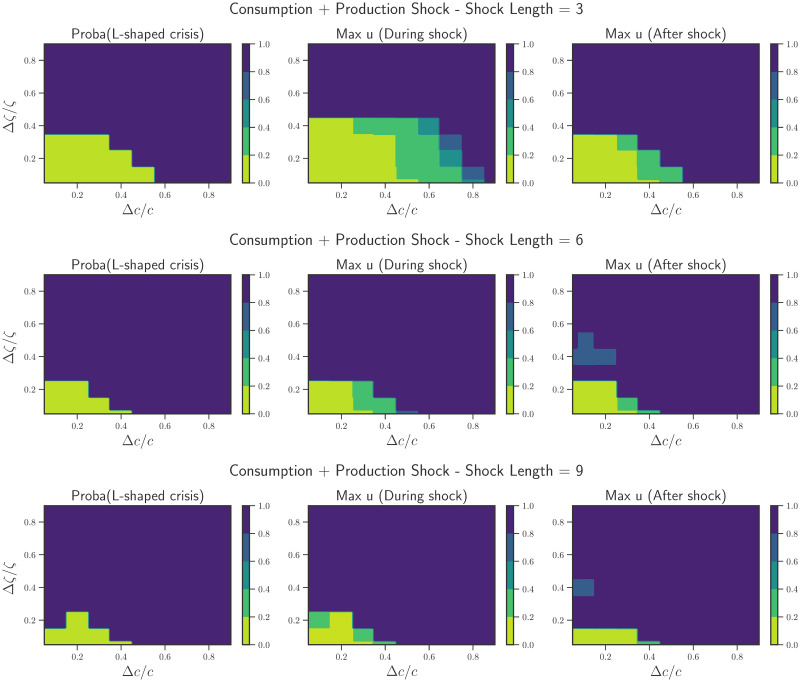
Phase diagrams in the Δc/c—Δζ/ζ plane for different shock lengths.Top Row: Shock lasting for 3 months. The region of parameter space with no L-shaped crisis is quite large allowing for strong consumption shocks (Δc/c ≲ 0.5) and mild productivity shocks (Δζ/ζ ≲ 0.3). Note that for such a short shock, the effects on unemployment are seen after the shock has ended. Middle Row: Shock lasts for 6 months. A decrease in the region of no-crisis is observed. Mild shocks (Δc/c ∼ 0.4) can also lead to prolonged crises. During the shock itself, extremely high rates of unemployment can be seen. Bottom Row: Shock lasts for 9 months. Only for extremely mild shocks does the economy not undergo a prolonged crisis. Each of the plots has been obtained by running 500 independent simulations for each pair Δζ/ζ—Δc/c presented here.